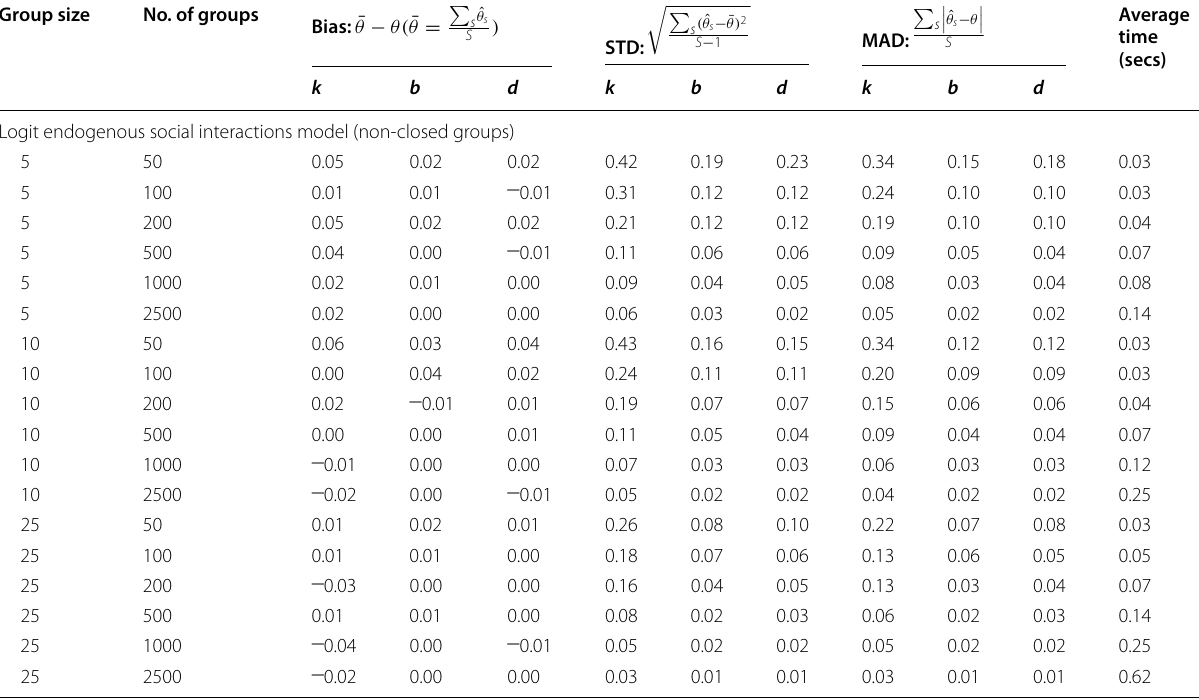
Table 2 Bias, standard deviation and mean absolute deviation of the estimates of the logit endogenous social interactions model with non-closed groups. 50 Monte Carlo simulations. Individuals are excluded from their own peer group Group